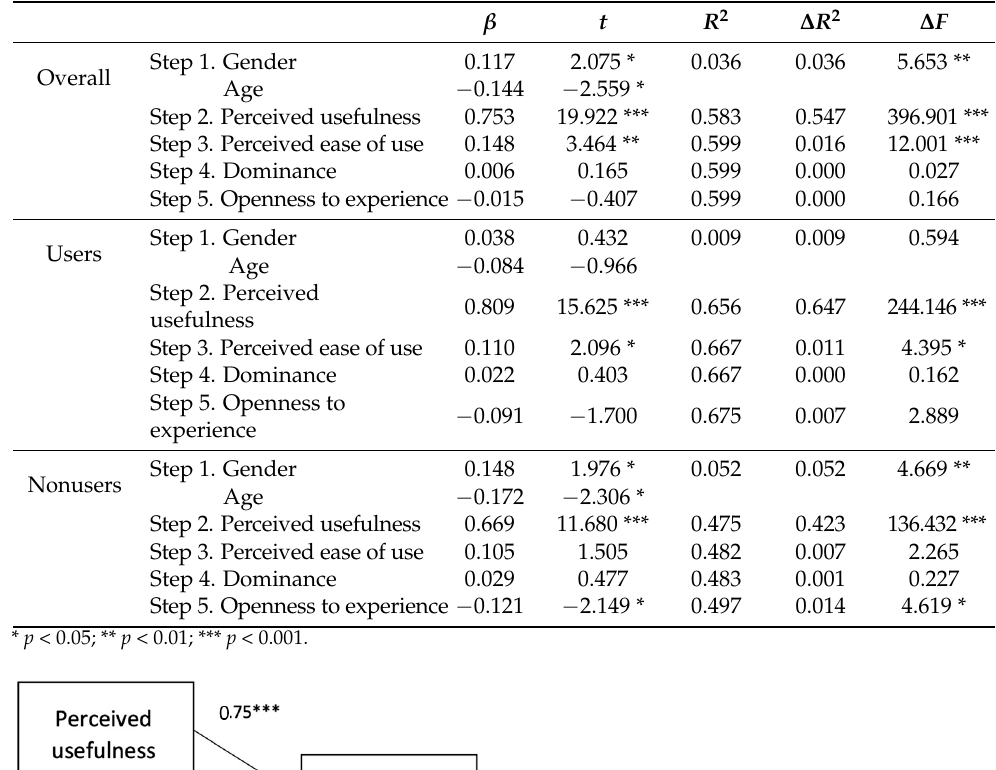
Table 3. Hierarchical regressions of attitude on perceived usefulness and ease of use.